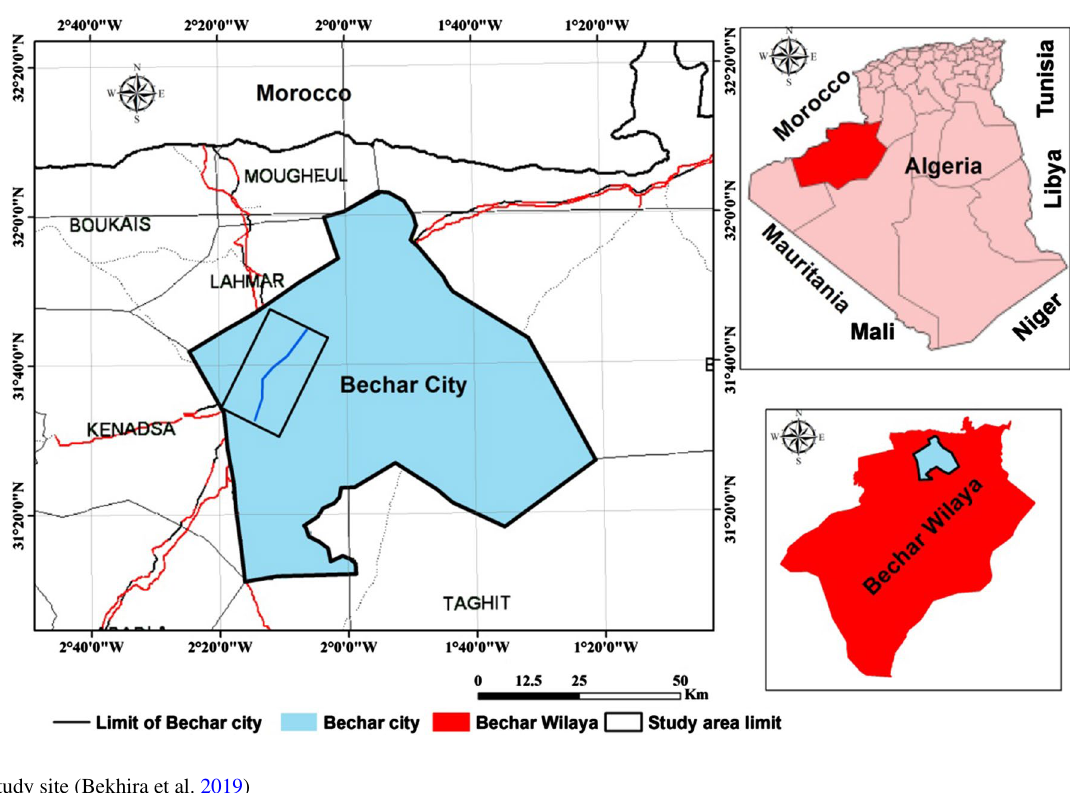
Fig. 4 Study site (Bekhira et al. 2019)